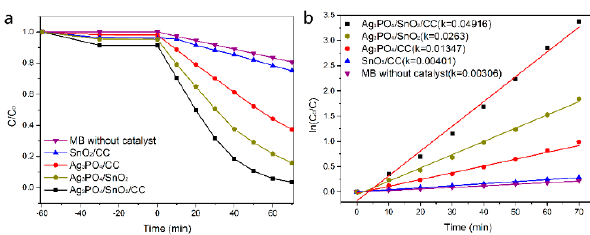
Figure 8. ( a ) Time-course variation of C/C 0 of MB over various catalysts, ( b ) The plots of ln(C 0 /C) versus time of various catalysts.